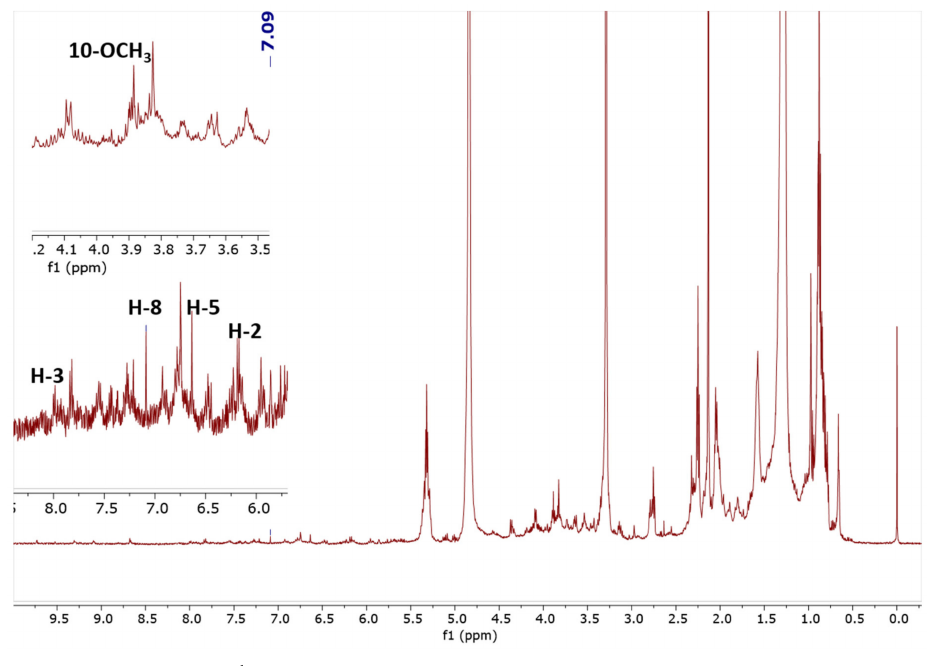
Figure 2. 1 H spectrum of Paederia foetida twigs chloroform extract.